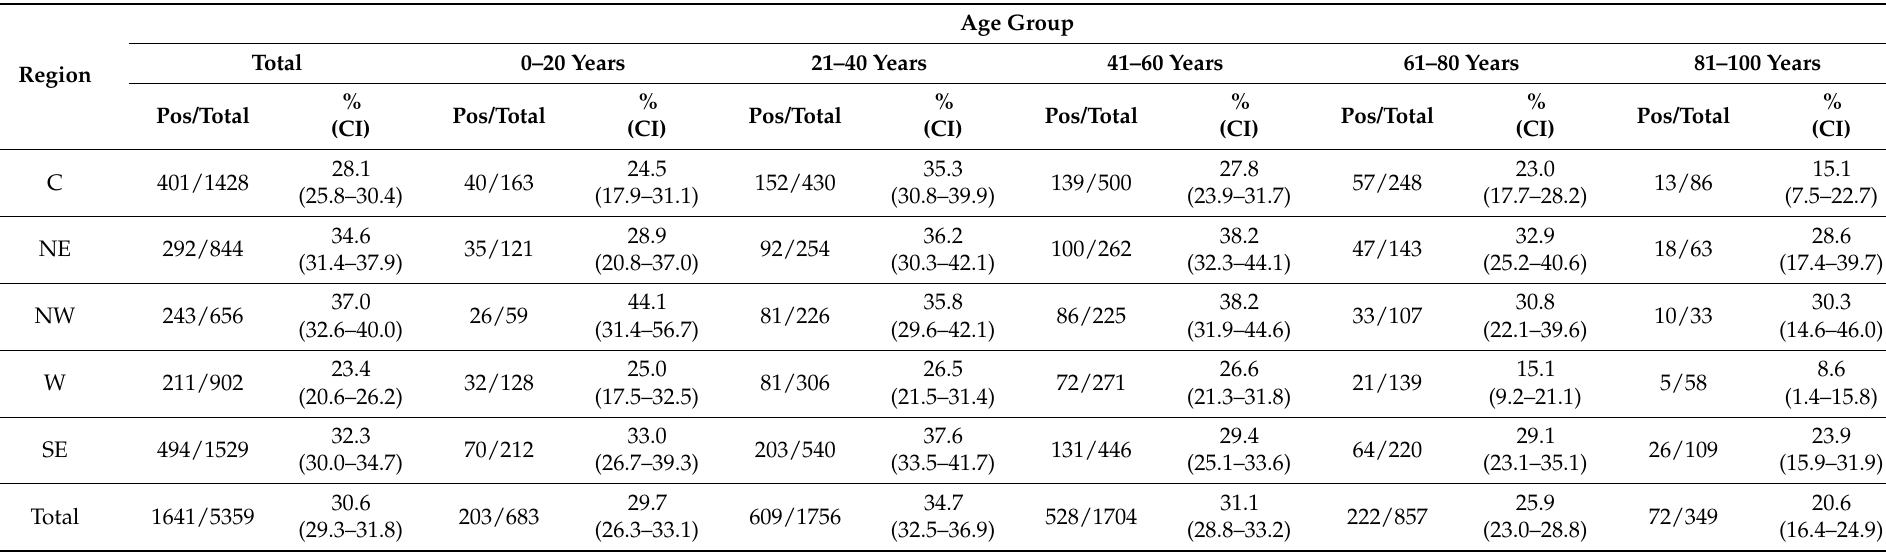
Table 2. Prevalence of neutralizing antibodies